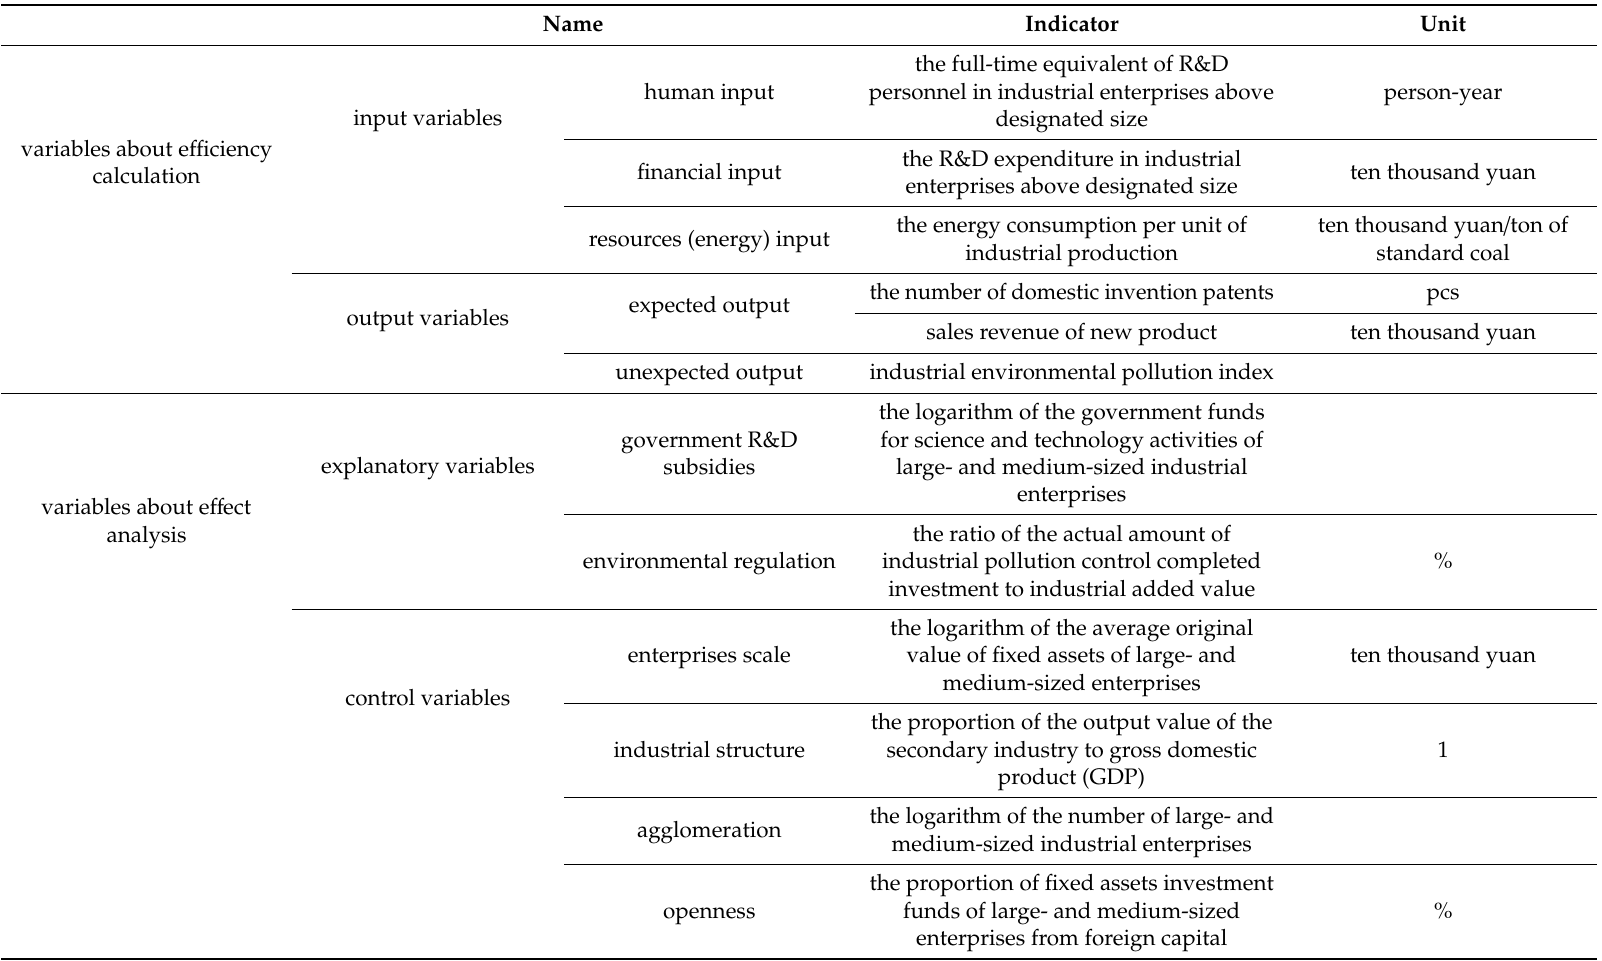
Table 1. Variable selection and